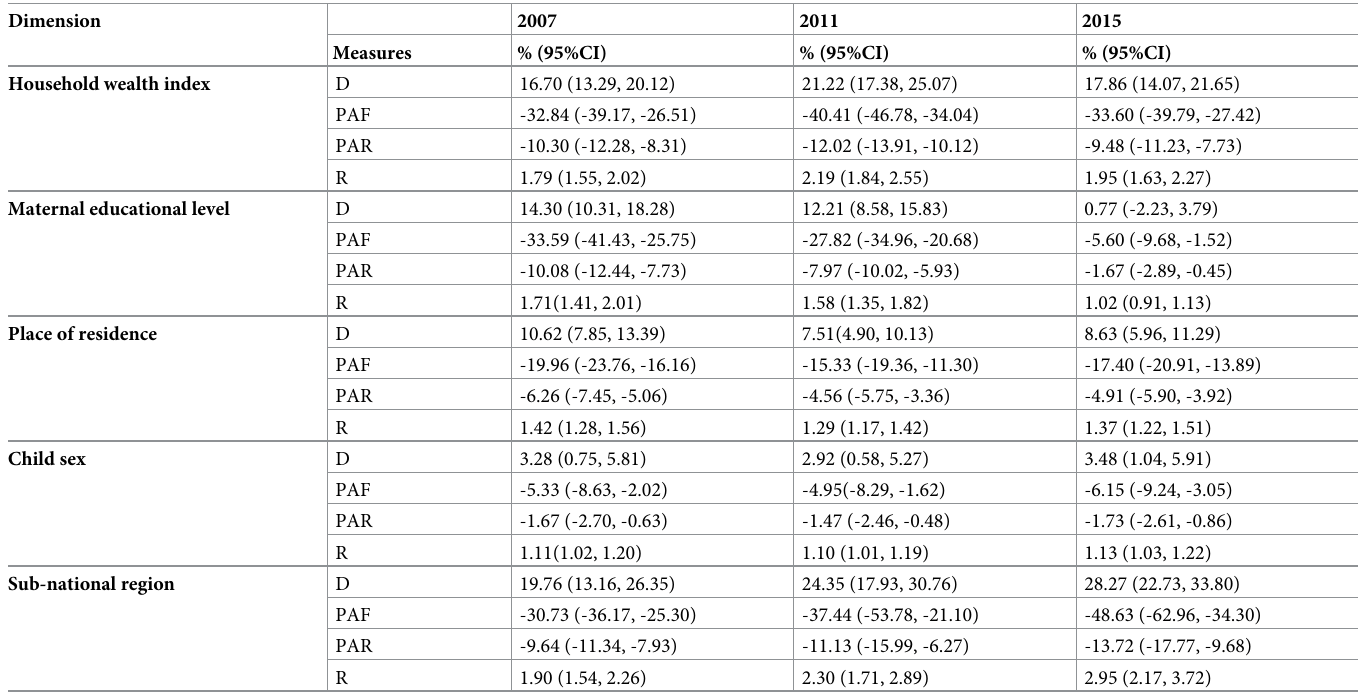
Table 2. Extent and over time trends of the socioeconomic and geographic inequalities in the childhood stunting in Mauritania, 2007–2015.